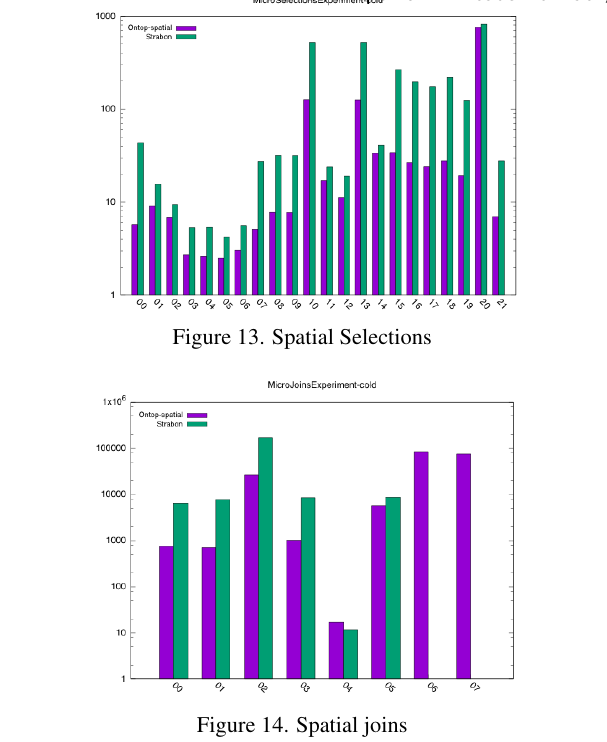
Figure 14. Spatial